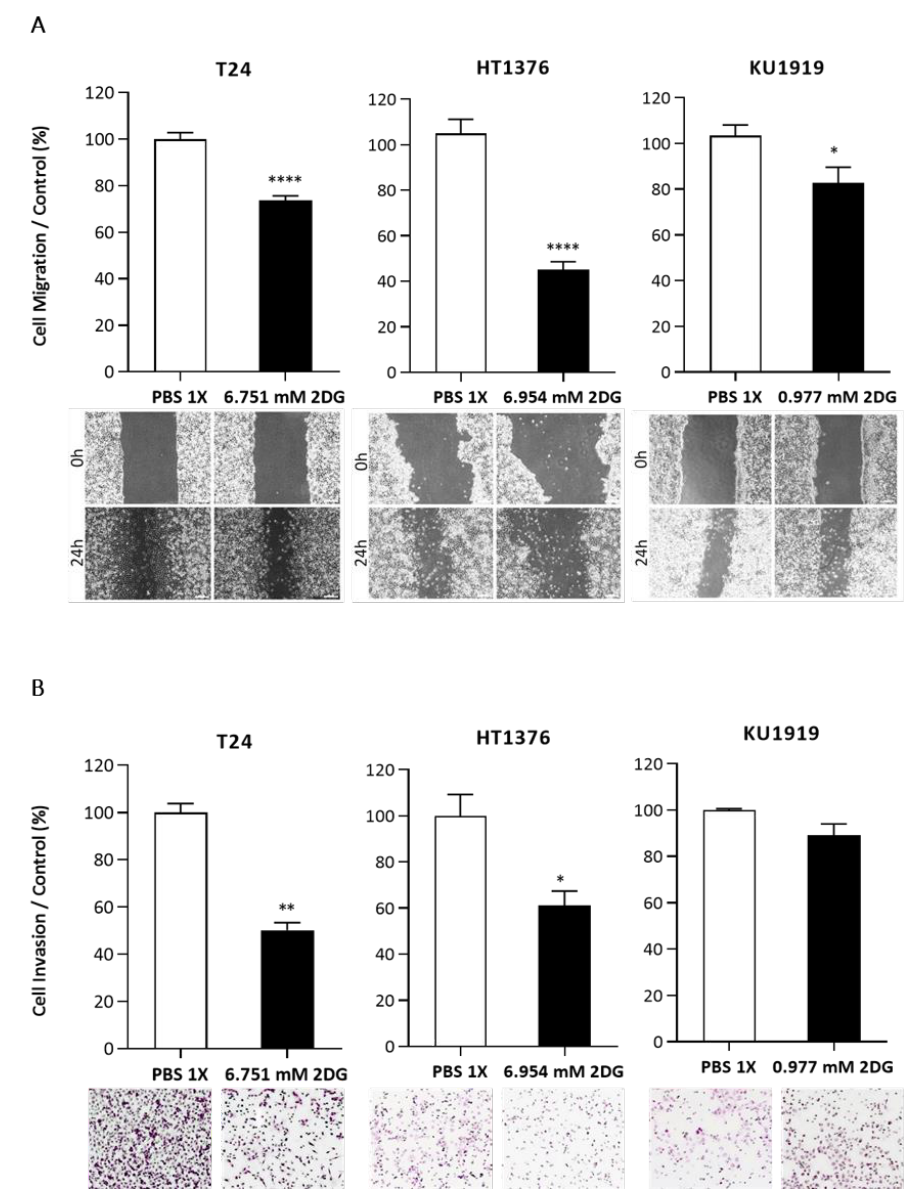
Figure 7. Effect of 2DG on the migration ( A ) and invasion ( B ) abilities of T24, HT1376, and KU1919 urothelial bladder carcinoma cell lines, detected by wound-healing assay ( A ) and by matrigel invasion chambers ( B ) at 24 h post-treatment. Representative pictures of the assays for each condition are shown. Results are expressed as the normalized mean ± SEM of at least 3 independent experiments. * p < 0.05, ** p < 0.01 and **** p < 0.0001 for 2DG IC 50 versus control condition (PBS 1×).